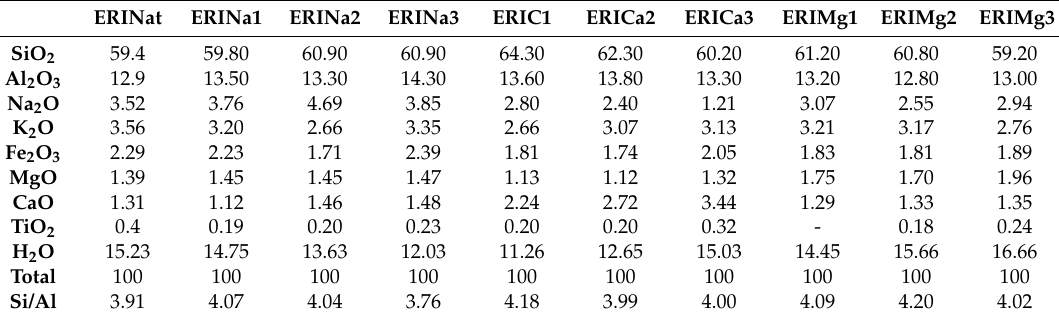
Table 2. Chemical composition of erionite zeolites by FRX (wt %).